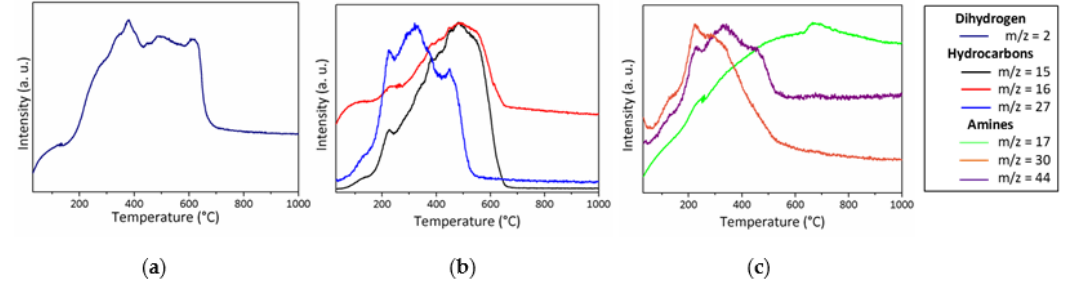
Figure 9. MS curves recorded during TG experiments of the PVMSZTi 2.5 sample in flowing argon: dihydrogen ( a ), hydrocarbons ( b ) and amines ( c ).